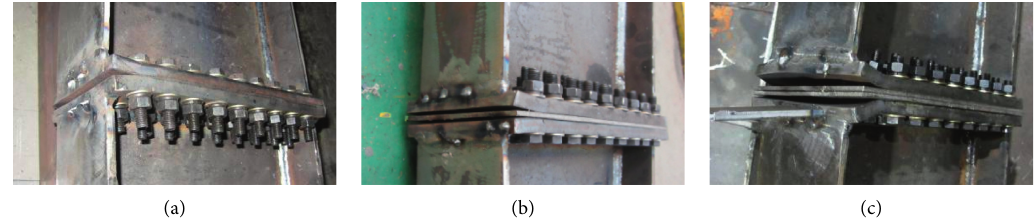
Figure 6: Typical failure mode of specimens under pure bending. (a) FLB-2-F0. (b) FLB-2-F1. (c)